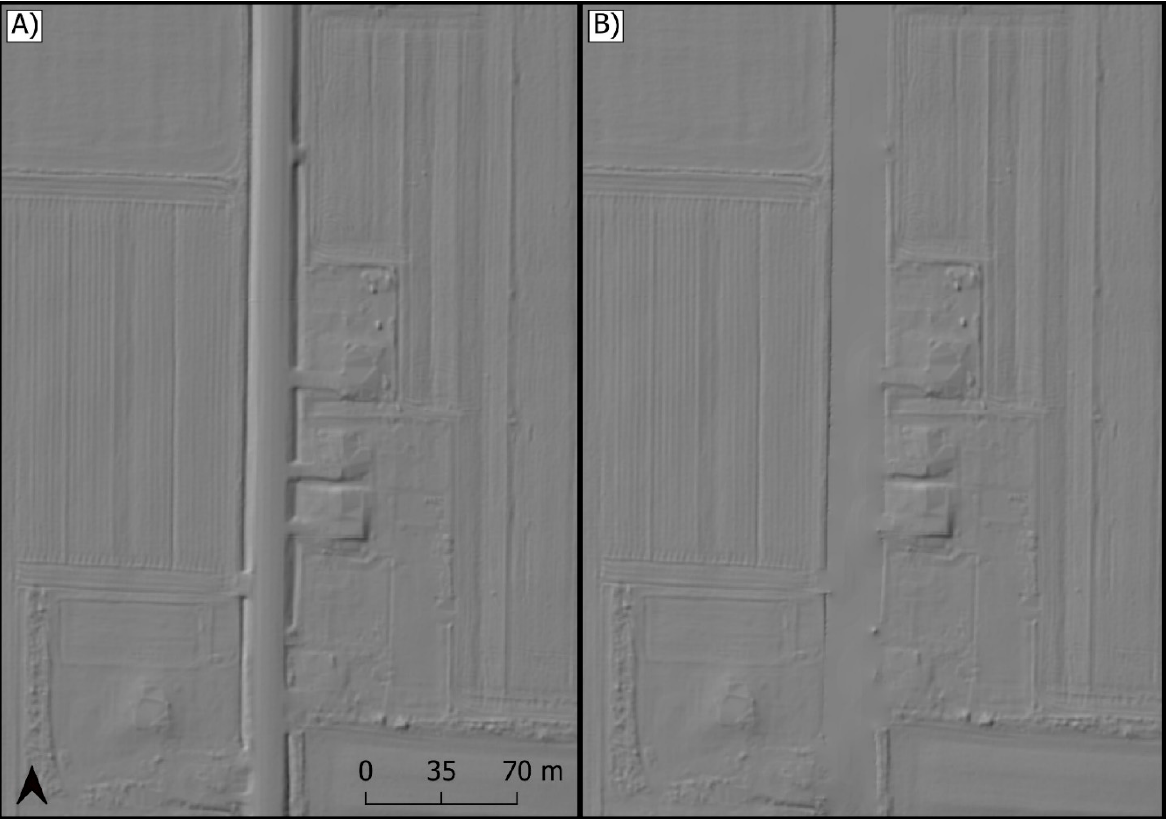
Figure 8. ( A ) A ditch-lined embankment; ( B ) The interpolated surface after the embankment was removed.